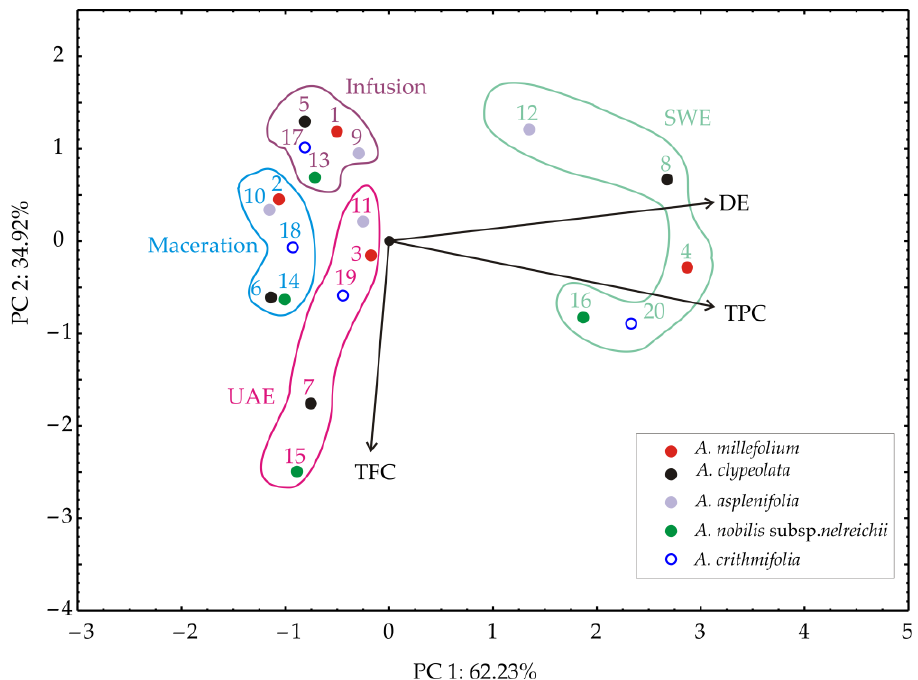
Figure 2. PCA biplot diagram depicting the relationships among Achillea samples regarding TPC, TFC and DE content. TFC and DE